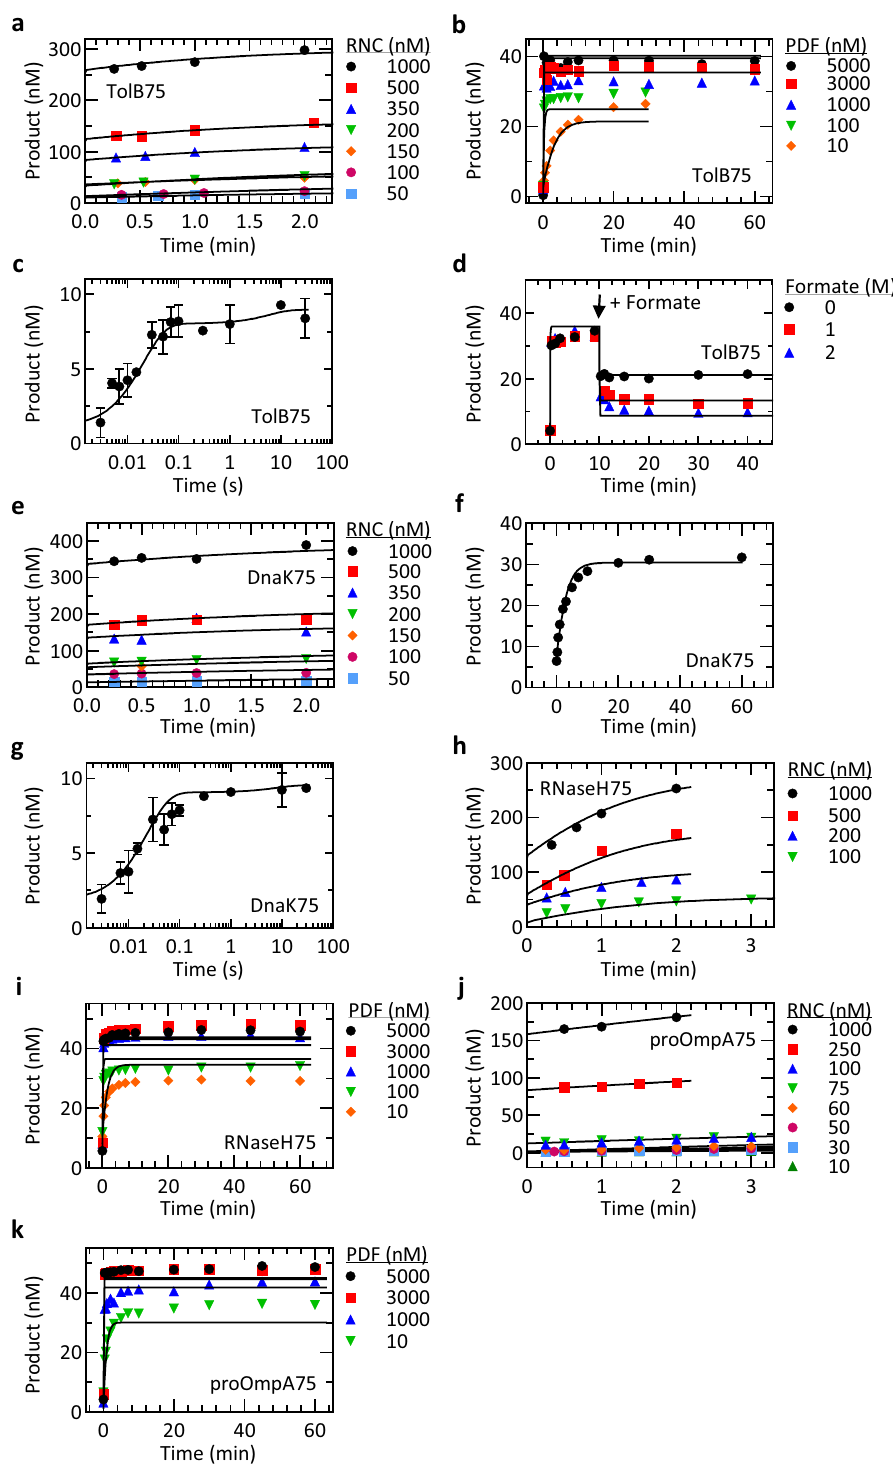
Figure 6. Global fit. All data of TolB75-RNC, DnaK75-RNC, RNaseH75-RNC and proOmpA75-RNC were used for global fitting in KinTek Explorer (“Materials and methods”). TolB75-RNC: ( a ) Multiple-turnover kinetics; ( b ) PDF titration; ( c ) Single-turnover deformylation kinetics; ( d ) Deformylation with addition of formate. DnaK75-RNC: ( e ) Multiple-turnover kinetics; ( f ) Extended time course with PDF (10 nM) and RNC (50 nM); ( g ) Single-turnover kinetics. RNaseH75-RNC: ( h ) Multiple-turnover kinetics; ( i ) PDF titration. proOmpA75-RNC: ( j ) Multiple-turnover kinetics; ( k ) PDF titration. Solid lines depict the simulated concentrations based on the global fitting results of this figure. Error margins in ( c , g ) are standard deviations of independent experiments (n = 3 (TolB75) and n = 4